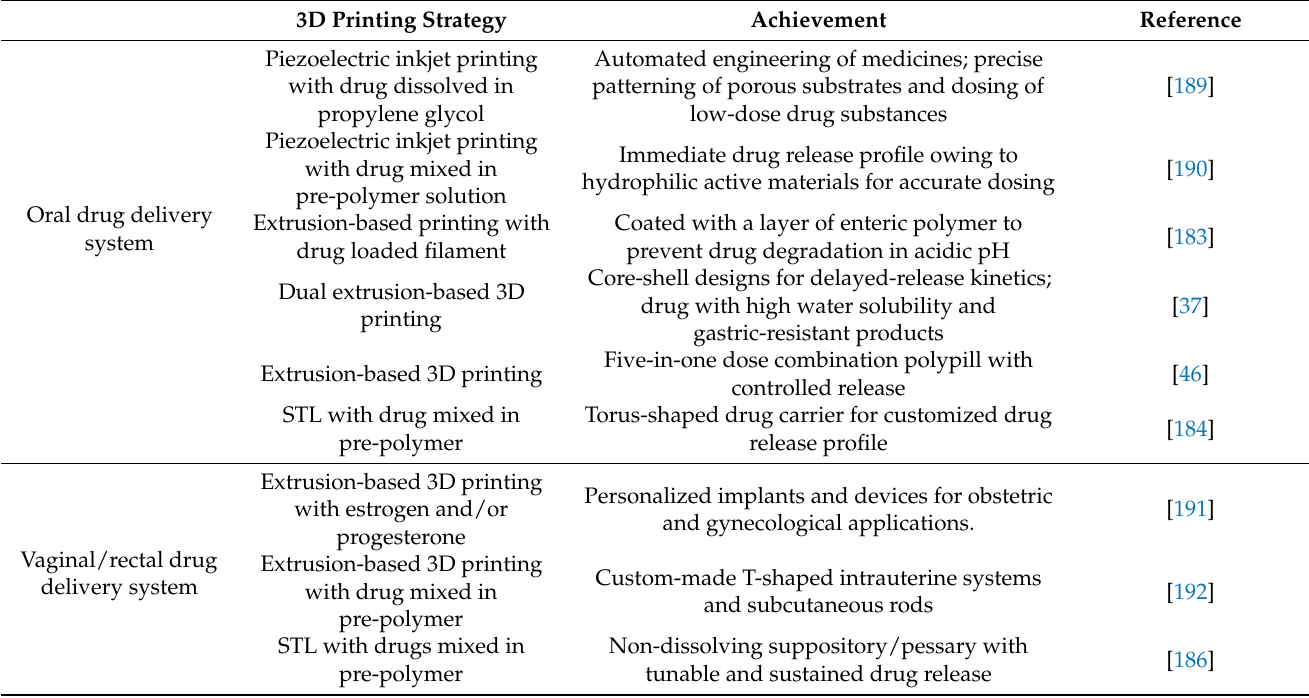
Table 2. Representative pharmaceutical application of 3D printed oral/vaginal/rectal drug delivery. 3D Printing Strategy Achievement